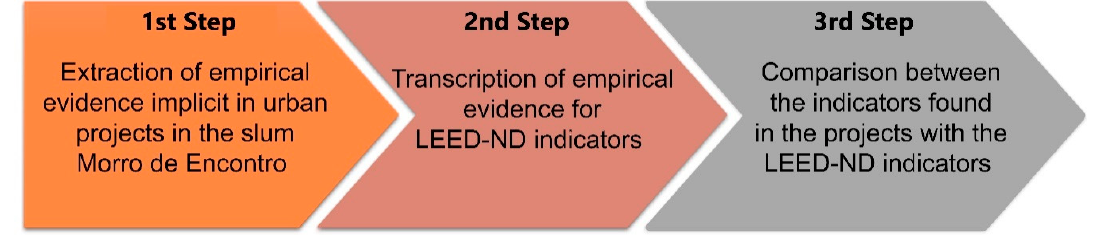
Figure 4. Data collection steps.